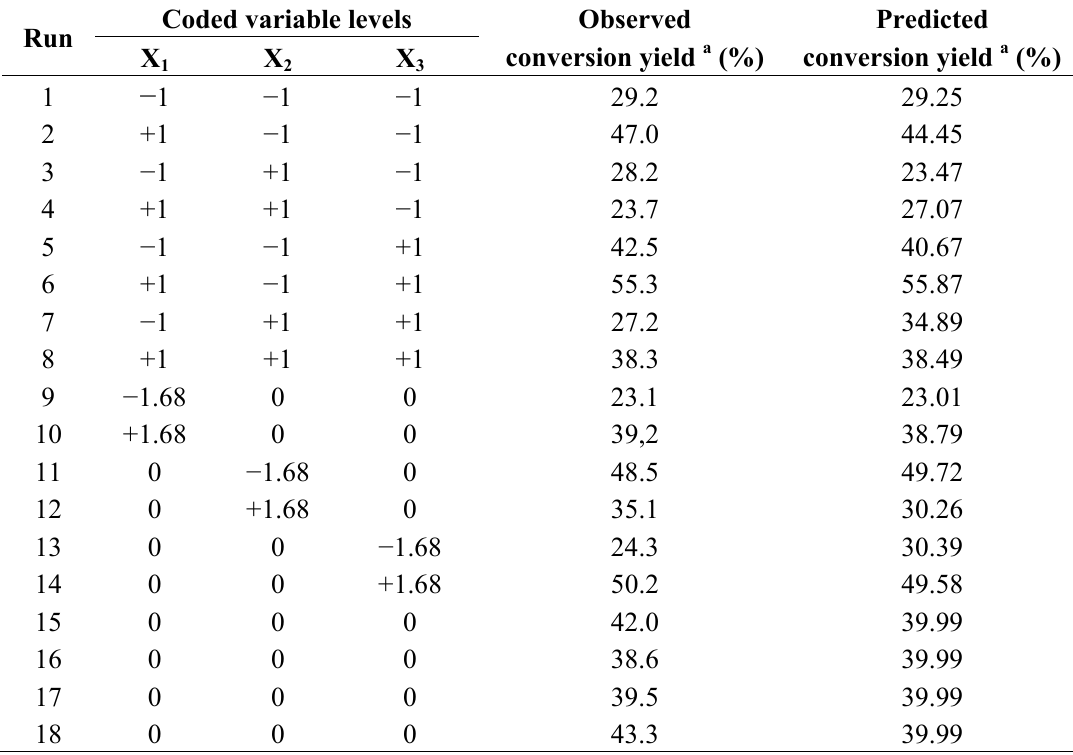
Table 2. Central composite design and responses in the enzymatic acylation of hesperidin with decanoic acid after 96 h of reaction.